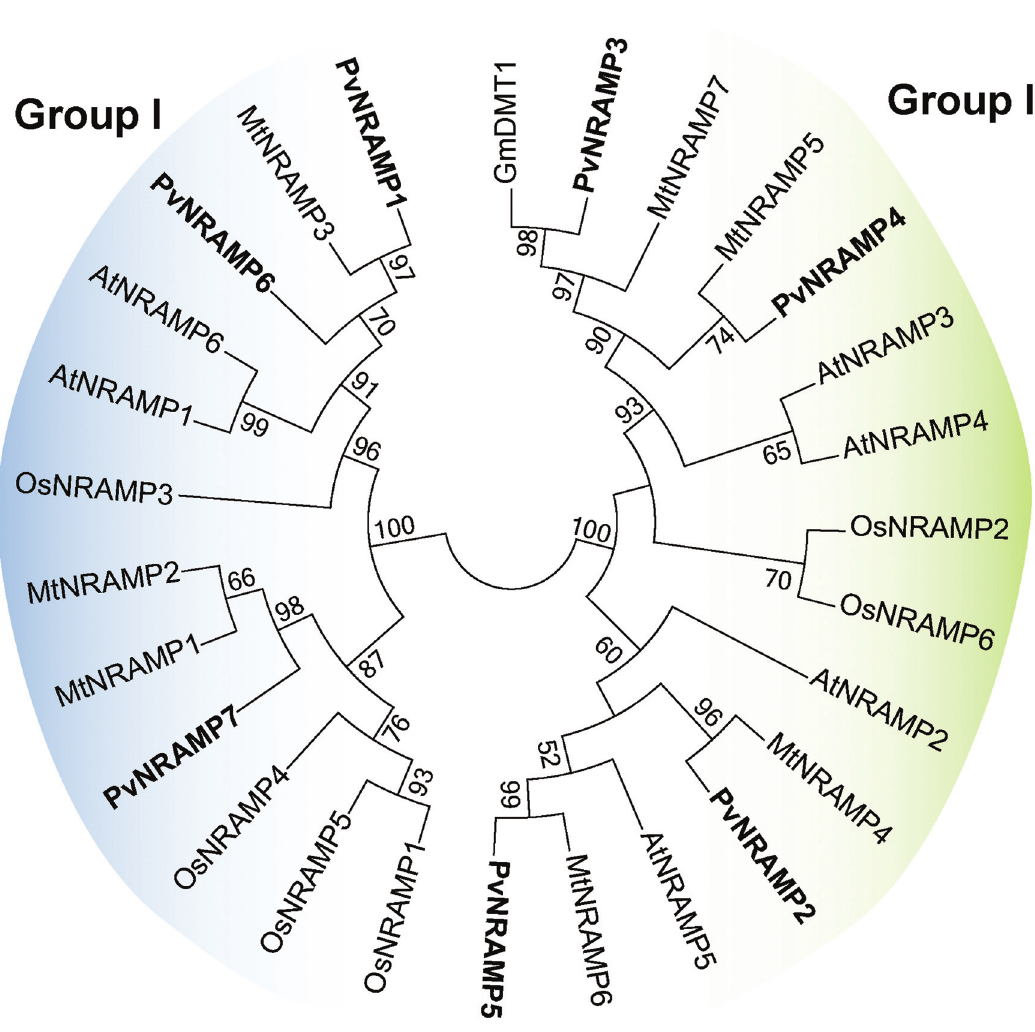
Figure 4 - Phylogenetic tree of NRAMP protein sequences. The unrooted tree was generated based on the Maximum Likelihood statistical method and the numbers at the internal node represent the percentage of 10,000 replicates in which the sequences are grouped in the bootstrap test. The different col- ors indicate the groups. The PvNRAMP protein sequences are in bold: PvNRAMP1 (Phvul.005G182000); PvNRAMP2 (Phvul.009G069700); PvNRAMP3 (Phvul.003G238600); PvNRAMP4 (Phvul.002G014300); PvNRAMP5 (Phvul.010G110500); and PvNRAMP7 (Phvul.009G127900). MtNRAMP1-MtNRAMP7 ( Medtr3g088460, Medtr3g088440, Medtr2g104990, Medtr3g102620, Medtr5g016270, Medtr8g028050 , and Medtr4g095075 , respectively) and representative plant NRAMP homologues: AtNRAMP1-7 ( At1g80830 , At1g47240 , At2g23150 , At5g67330 , At4g18790 , and At1g15960 , respectively) and OsNRAMP1-6 ( Os07g0258400 , Os03g0208500 , Os06g0676000 , Os01g0503400 , Os07g0257200 , and Os12g0581600 , respectively). The TjNRAMP4 (Q7XB56), TcNRAMP4 (DQ418489), TcNRAMP3 (EF639294), and GmDMT1 ( Glyma17g18010